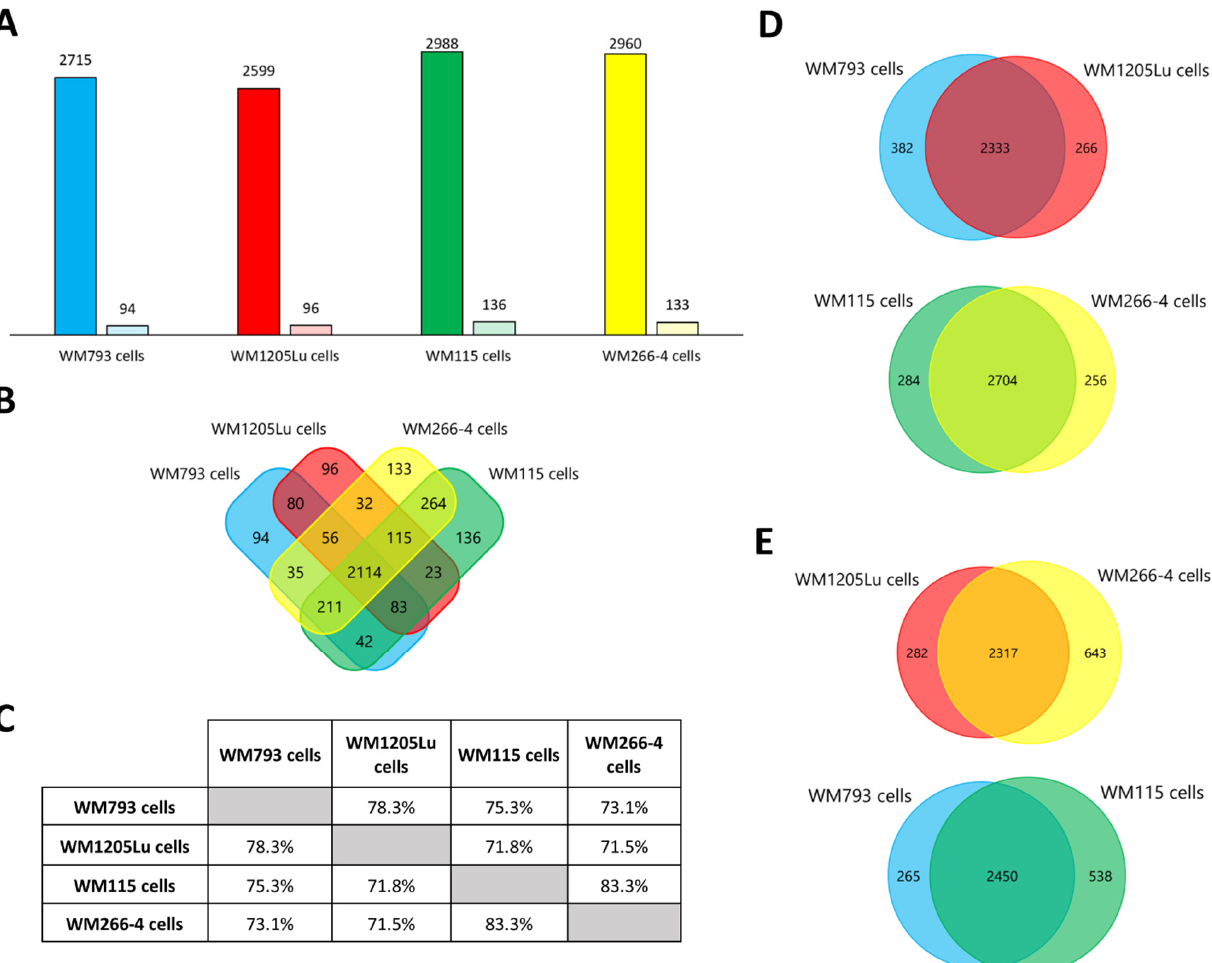
Figure 3. Qualitative analysis of proteins identified in CM cells by LC-MS/MS. ( A ) Number of proteins identified (by at least two peptides) in at least three out of four biological replicates of each CM cell sample (left bar) and the number of unique proteins (right bar). ( B ) Number of proteins shared between given CM cell lines. ( C ) Percentage of proteins shared between given CM cell lines. Number of proteins shared between isogenic ( D ) and primary or metastatic CM cell lines ( E ). WM115/WM266-4,WM793/WM1205Lu—isogenic pairs (primary/metastatic) of CM cell lines that were analyzed. Complete protein lists are presented in Supplementary Data